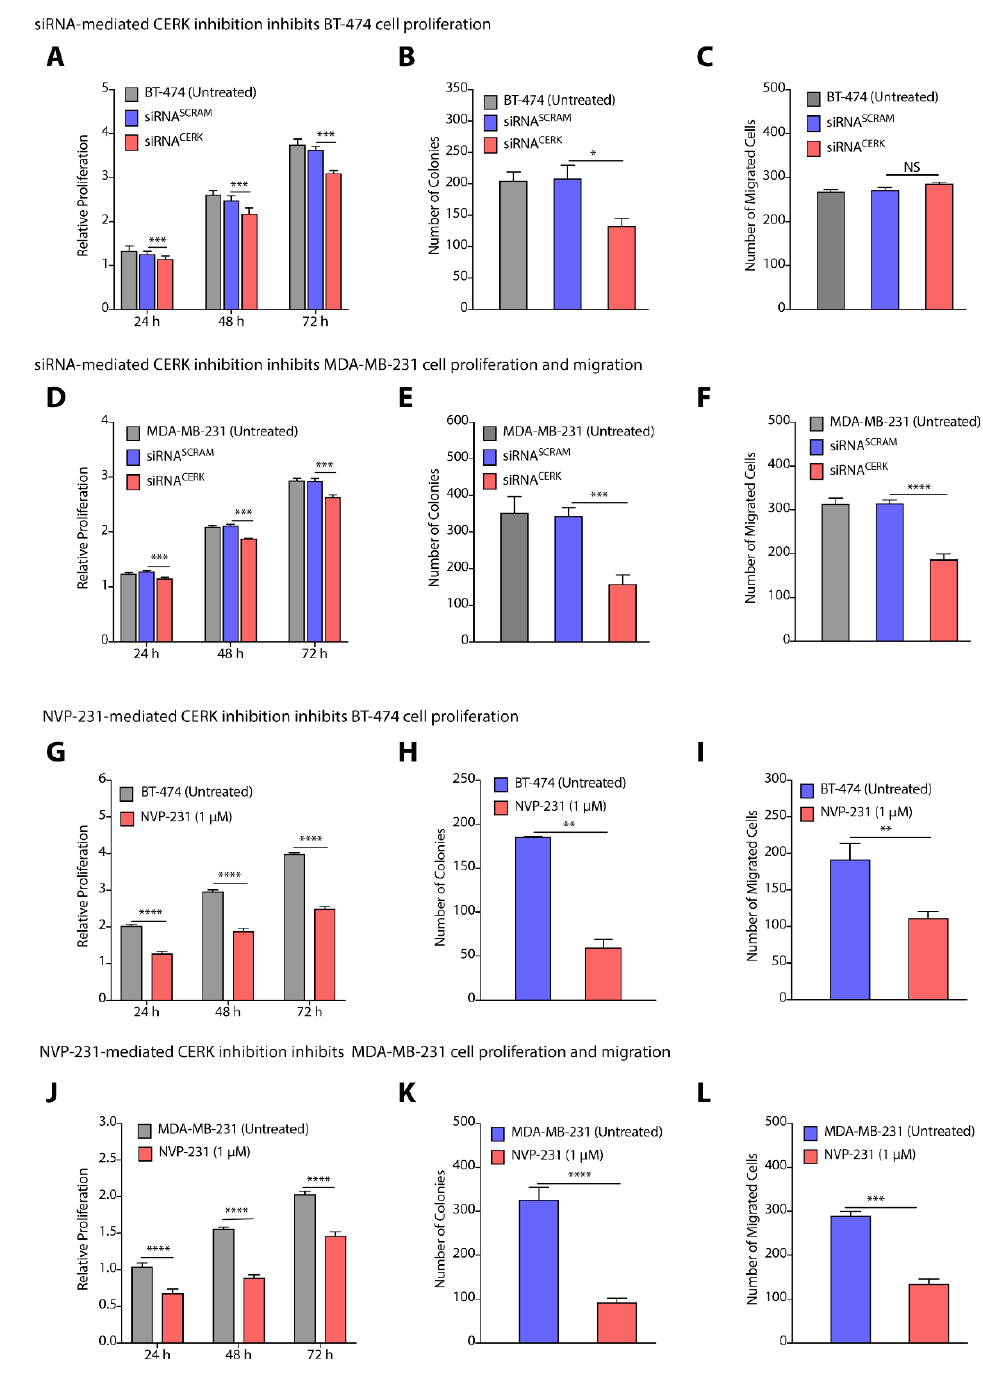
Figure 6. ( A – F ) Change in proliferation ( A , D ), colony forming units ( B , E ), and number of migrated cells ( C , F ) on siRNA-mediated knockdown of CERK in BT-474 ( A – C ) and MDA-MB-231 ( D – F ) cells. ( G – L ) Change in proliferation ( G , J ), colony forming units ( H , K ), and number of migrated cells ( I , L ) on NVP-231-mediated inhibition of CERK in BT-474 ( G – I ) and MDA-MB-231 ( J – L ) cells. Data are presented as mean ± SEM of at least three independent replicates, and were analyzed by unpaired student’s t -test. p -value: ** p < 0.01, *** p < 0.001, **** p < 0.0001.